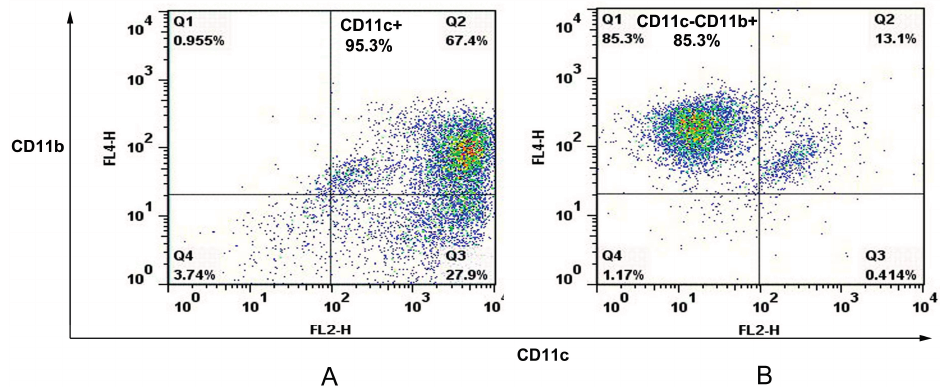
Figure 1. Cell sorting of murine splenic M Φ s and DCs. In this case, the single spleen cell suspension of C57/BL6 mice was first stained with anti-CD11c Microbeads before autoMACS separation led to a positive cell sample of CD11c + cells (Q2 and Q3) with purity of 95.3% ( A ); The negative fraction was further incubated with anti-CD11b Microbeads giving a positive cell fraction containing CD11c − CD11b + cells (Q1) with purity of 85.3% ( B ).